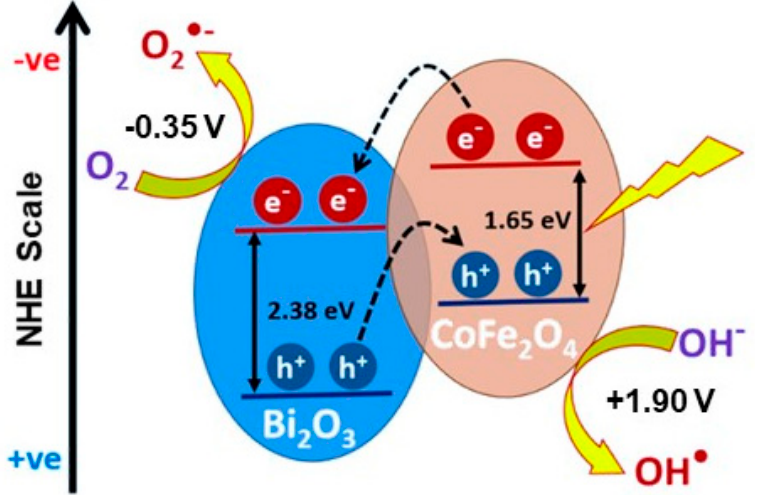
Figure 8. Schematic illustration of energy level alignment and photodegradation action of Bi 2 O 3 / CoFe 2 O 4 nanocomposites.